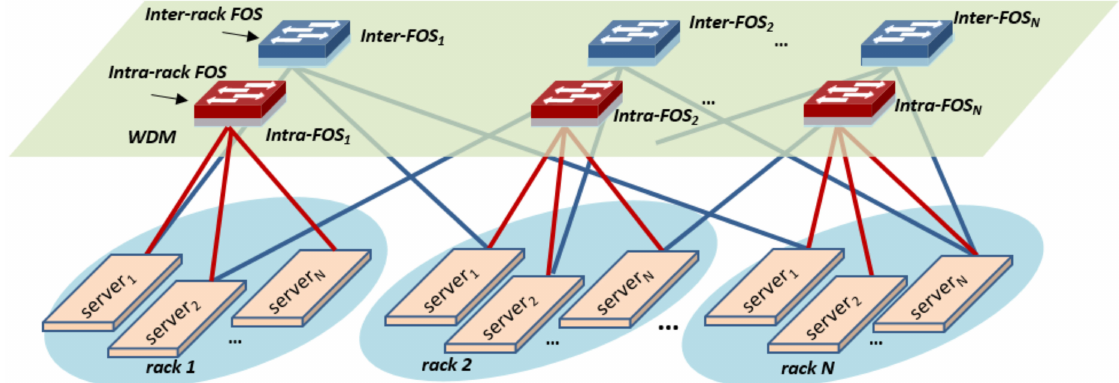
Figure 1. The FOSquare High-Performance Computing (HPC) architecture based on fast optical switch with flow control.